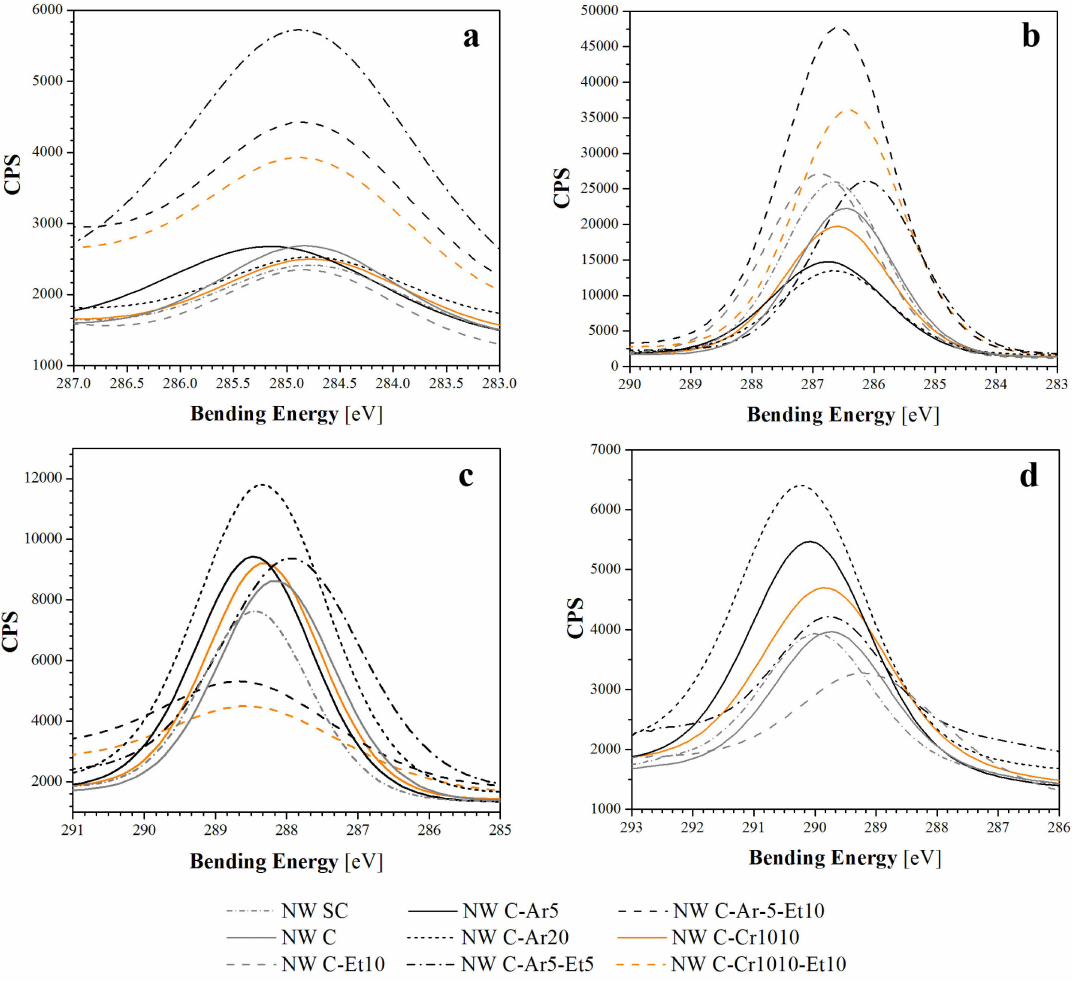
Figure 8. Comparative of the C1s peaks found in the deconvolution curves: ( a ) for the C1-peaks of all samples; ( b ) for the C2-peaks; ( c ) for the C3-peaks; ( d ) for the